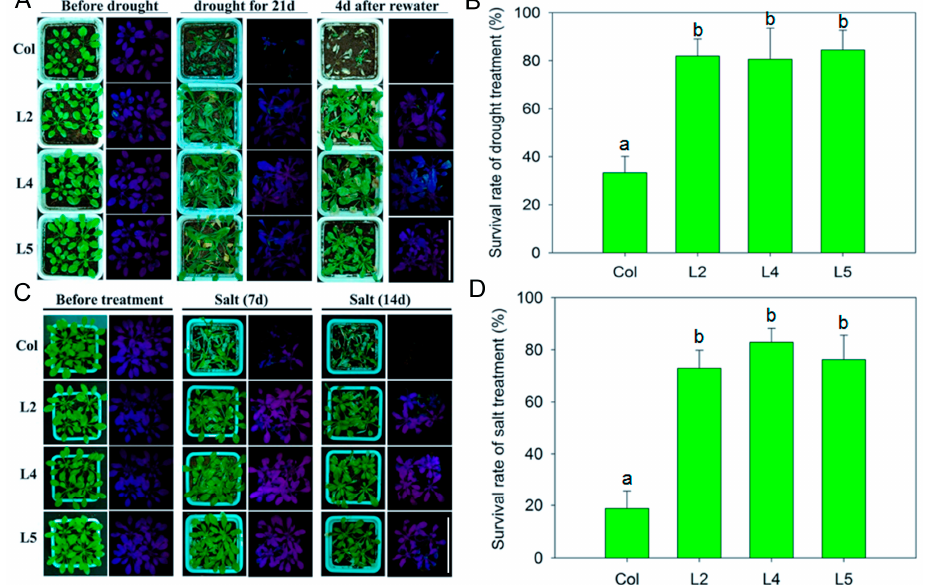
Figure 4. Effect of drought and salt stress on the seedling growth and survival rate of SpCIPK26 -OXP and WT planted in soil: ( A , B ) phenotype and photosynthetic efficiency ( F v/ F m) comparison between SpCIPK26 -OXP and WT in response to drought and salt treatment, respectively; and ( C , D ) survival rate of SpCIPK26 -OXP and WT after drought and salt stress. Drought treatment was imposed by continuously withholding water to soil-grown plants and salt was done by irrigating 30 mL NaCl solution every day at the concentration of 150 mM. All treatments were replicated six times biologically. Error bar denotes standard deviation, and different letters above the bars signify significant difference between wild type (control, Col) and transgenic lines (L2, L4 and L5) at p < 0.01. Bar = 10 cm.